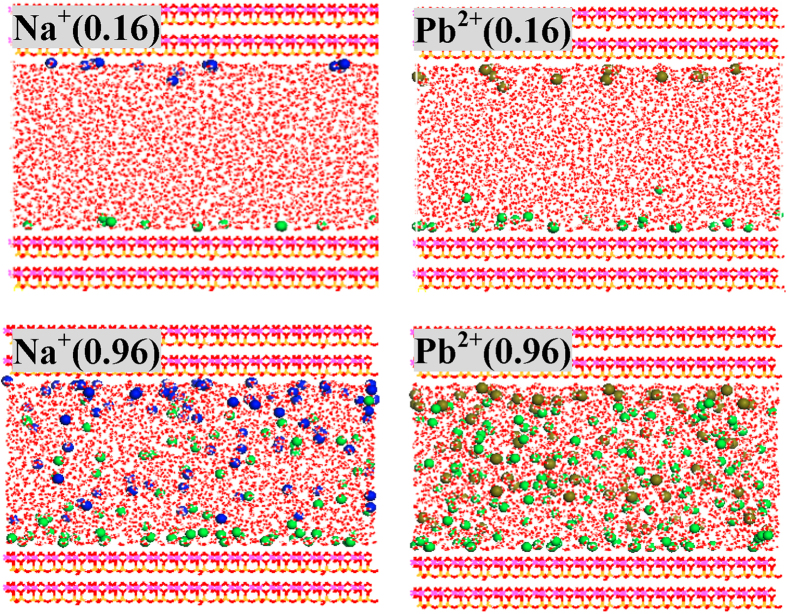
Configurations of defective kaolinite (Si2) in equilibration with 0.16 and 0.96 mol/L NaCl/PbCl2 solutions.Ionic concentrations (mol/L) are indicated in the parentheses of legends. Na+, Pb2+ and Cl− ions are represented as blue, dark yellow and green balls, respectively.